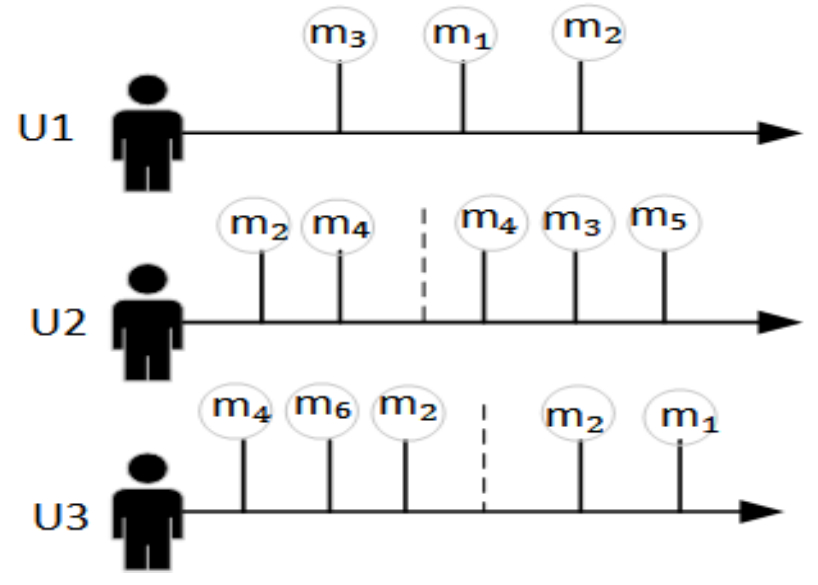
Figure 3. User behavior sequences.